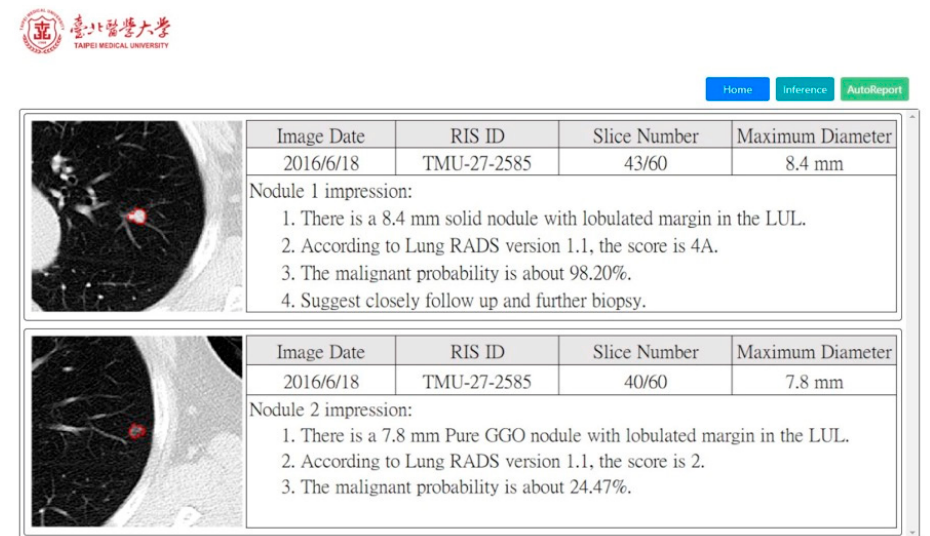
Figure 4. Illustration of the prototype image analysis and prediction system based on CT2Rep. On the left is the patient’s CT scan and segmented nodules. On the right are the basic metadata of the CT scan, as well as the generated descriptions, which integrates the information of Size, Location, Margin, Texture, and Lung-RADS. Here, two lung nodules were detected from the same patient. Noticeably, since these nodules were located in different slices and their characteristics were distinct from each other, different reports were generated accordingly. As demonstrated here, this system can effectively assist radiologists in discovering all suspected nodules first. Subsequently, false-positives will be judged and verified by radiologists.